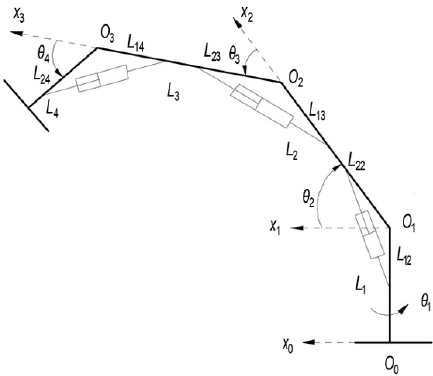
Figure 5. Simplified model of the manipulator .